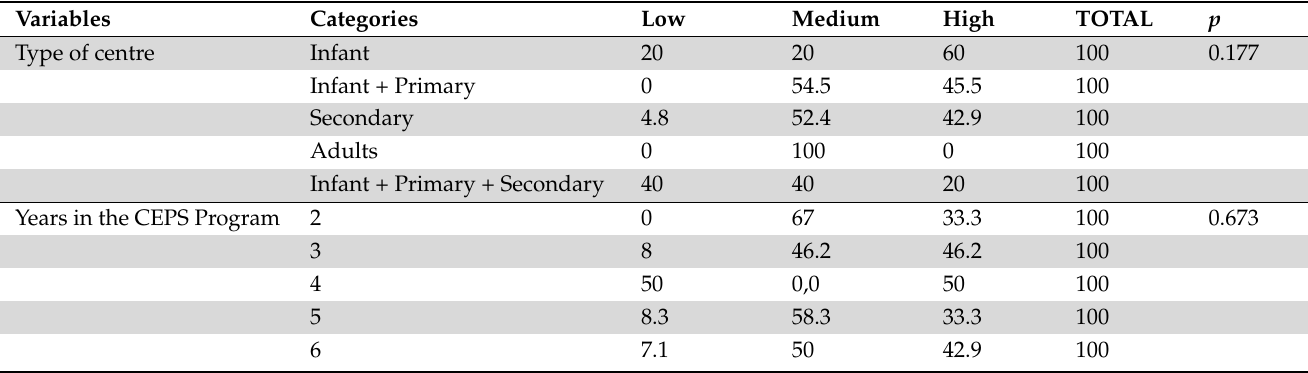
Table A1. Association between quality of the health project * and variables used for the evaluation of the CEPS Program (N =